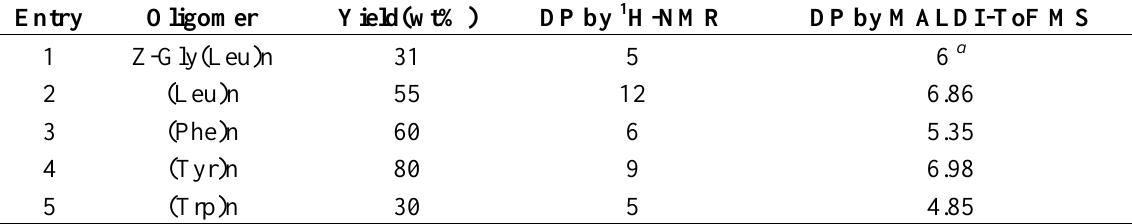
Table 1. Yield and DP of the Leu, Phe, Tyr and Trp